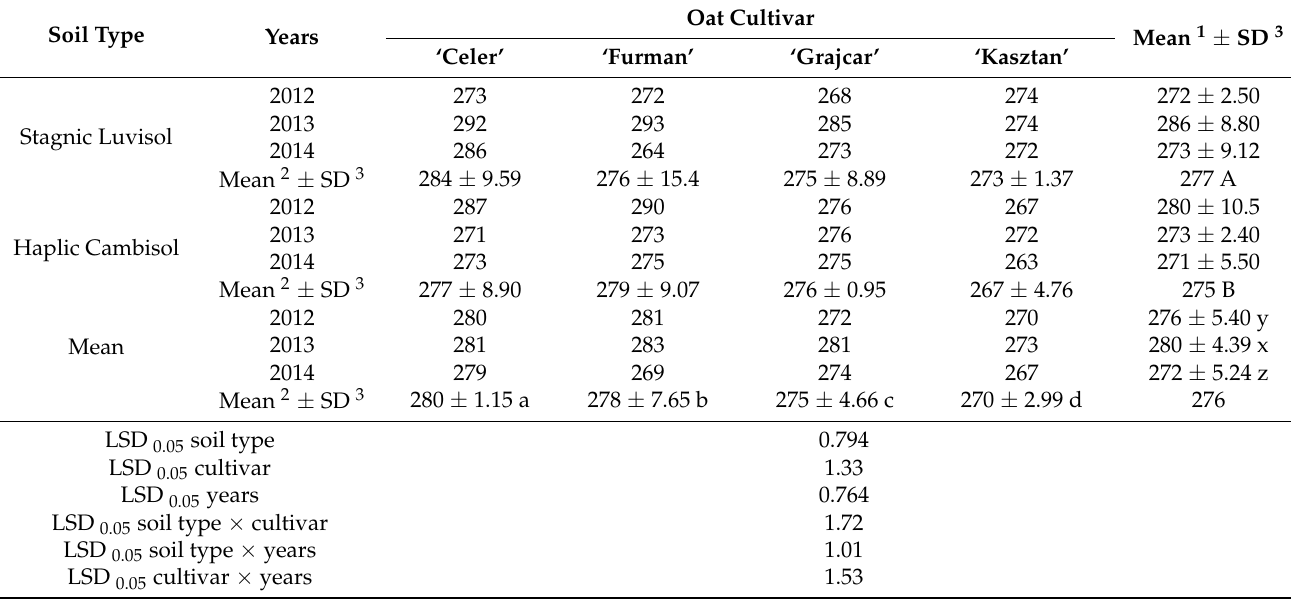
Table 16. Total protein content in vetch seeds (g kg − 1 ) grown in the mixtures, depending on the soil type (factor I), oat cultivar (factor II), and study years (factor